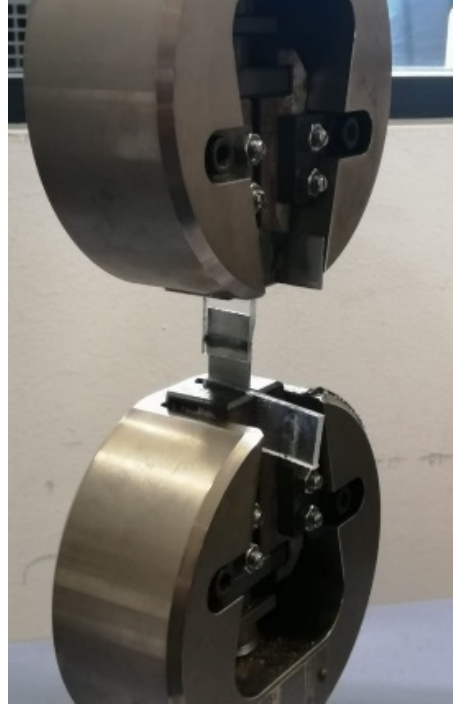
Figure 5. Tensile testing of the welded samples: tensile-shear configuration.